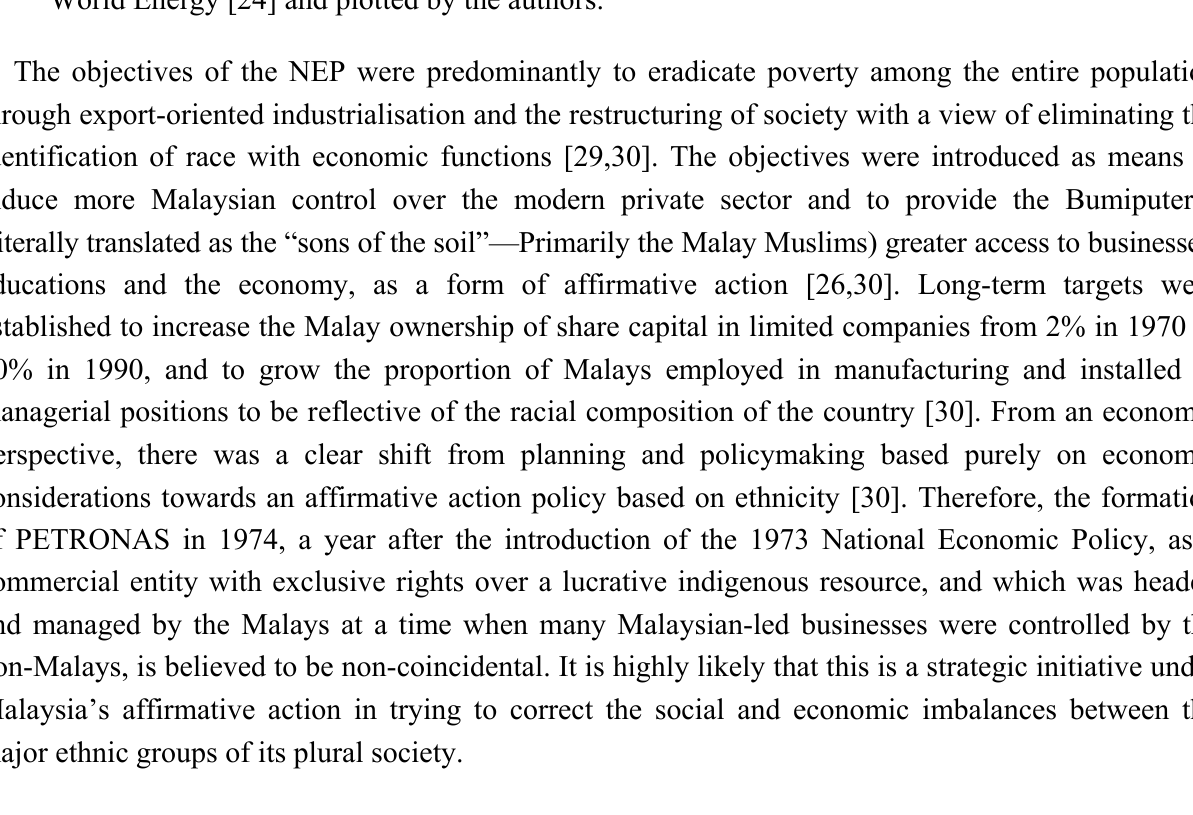
Figure 1. The prices of crude oil from 1861 to 2010 based on the actual $ at the time. Prices not corrected for inflation. Data were obtained from the BP Statistical Review of World Energy [24] and plotted by the